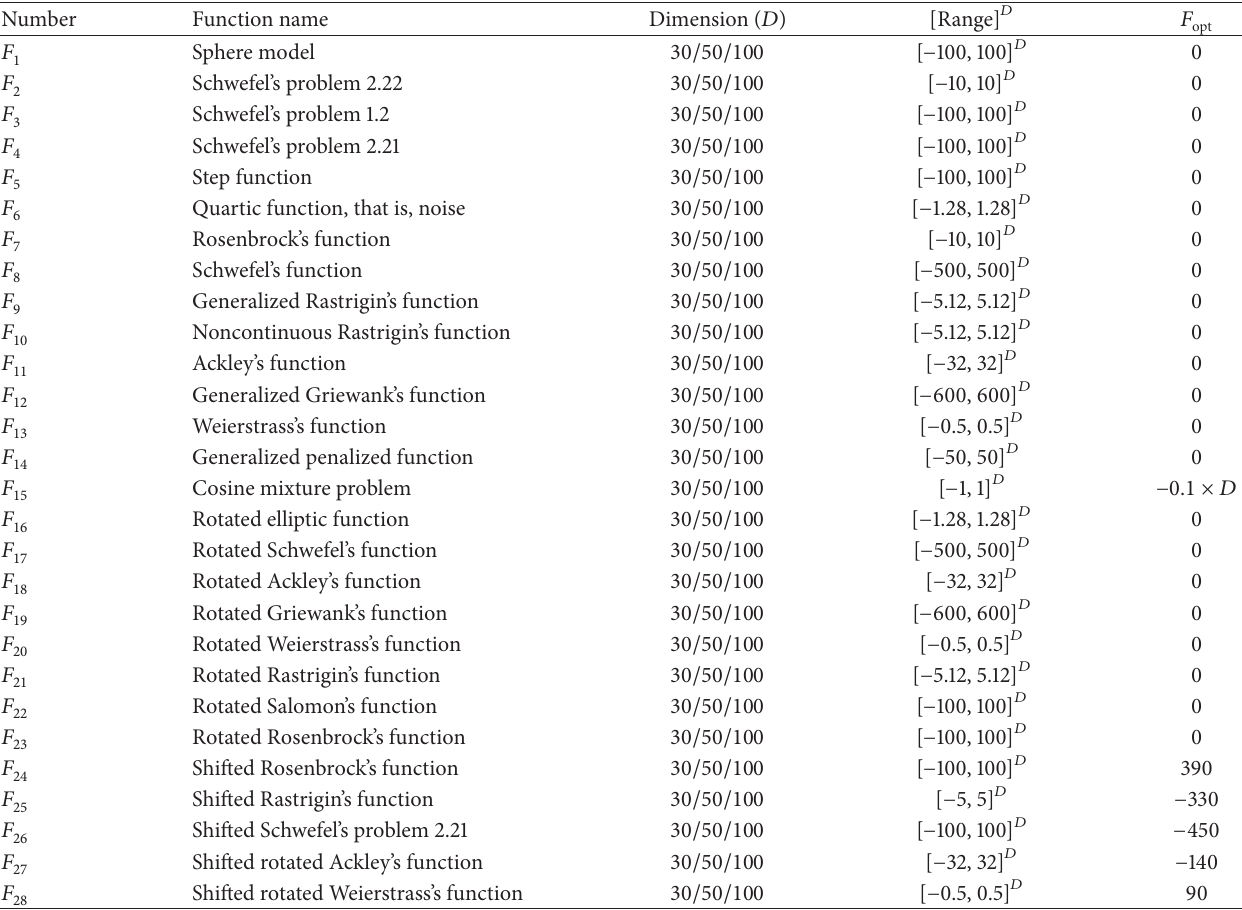
Table 1: Functions’ names, dimensions, ranges, and global optimum values of benchmark functions used in the